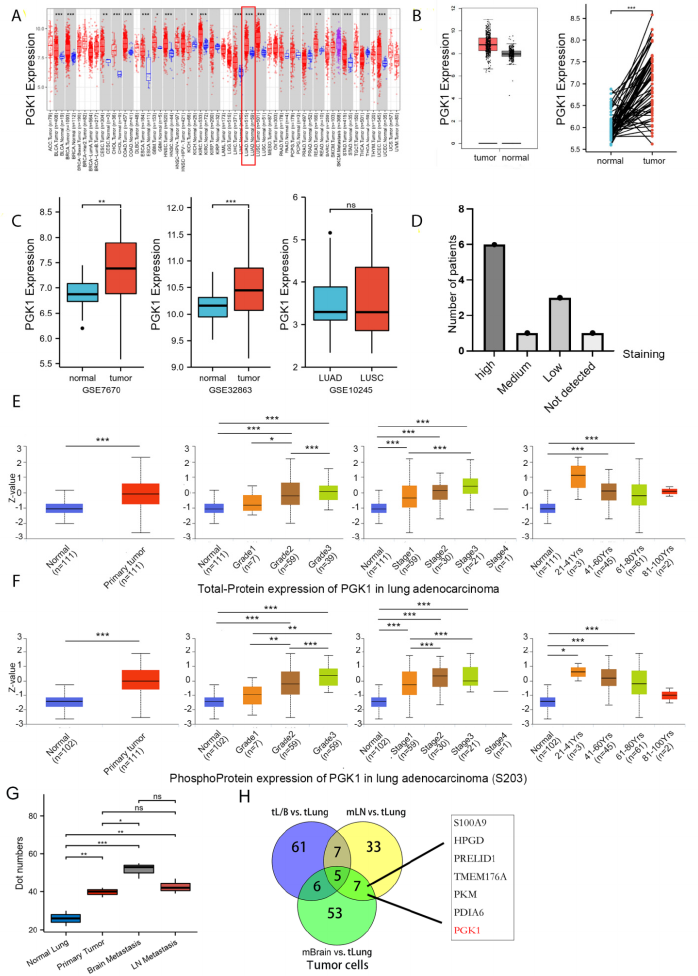
Figure 1. PGK1 expression levels in pan-cancer and LUAD contexts: ( A ) From the TCGA database, PGK1 mRNA expression levels in pan-cancer context. ( B ) PGK1 mRNA expression levels in LUAD, in comparison to healthy tissue taken from the TCGA database. ( C ) Levels of PGK1 mRNA expression in LUAD from two different GEO data sets, as well as in LUAD and LUSC. ( D ) Expression levels of PGK1 protein in LUAD and LUSC from the HPA database. ( E ) Expression levels of PGK1 total- protein in different clinical characteristics of LUAD from the CPTAC database. ( F ) Levels of PGK1 phosphoprotein expression in various LUAD clinical traits taken from the CPTAC database. ( G ) The expression of PGK1 in different tissues including primary and metastatic lesions was obtained from the single-cell database GSE131907. ( H ) The Venn map of differential gene of tumor cells in different metastatic tumor cells vs. lung primary tumor cells. tL/B vs. tLung: Lung metastasis vs. primary lung cancer; mBrain vs. tLung: Brain metastasis vs. primary lung cancer; mLN vs. tLung:Lymph node metastasis vs. primary lung cancer. (dot numbers are the number of cells in a fixed area) (* p < 0.05, ** p < 0.01, *** p < 0.001, ns >